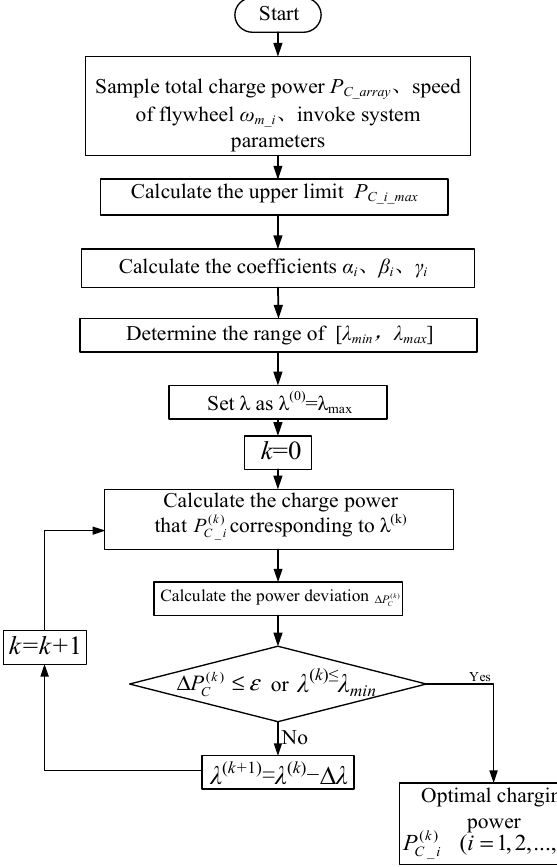
Figure 10. Flow sheet of charging coordination control based on the equal incremental principle (EIP).